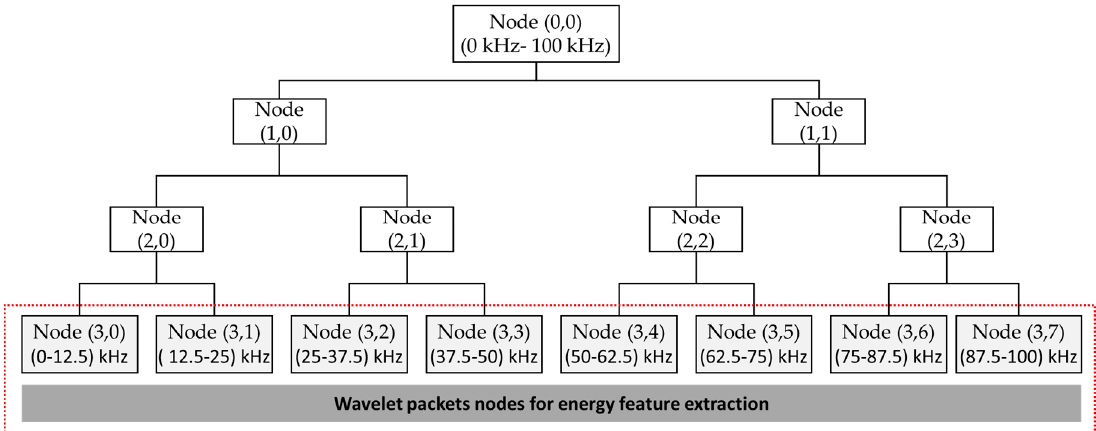
Figure 5. The decomposition method of WPT up to three levels for extracting energy features.